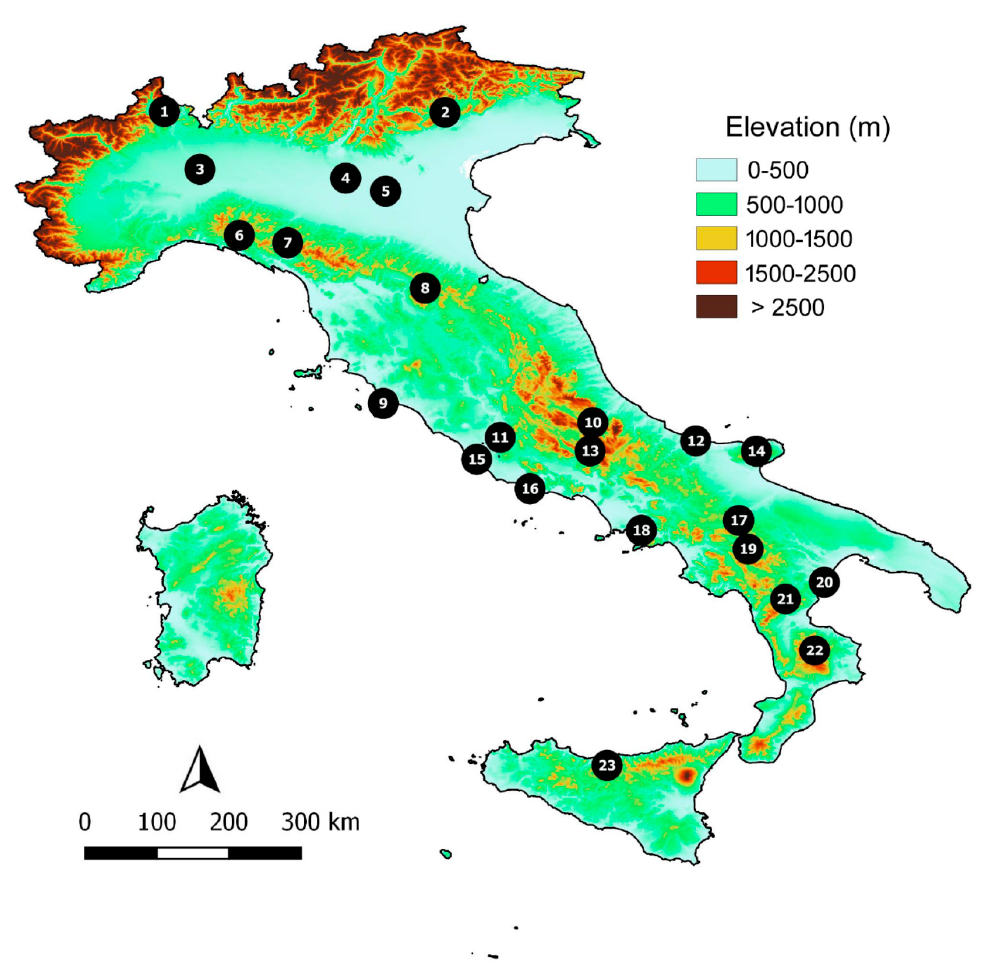
Figure 1. Location of the 23 Italian reserves considered in this study. Reserve names are given in Table 1.